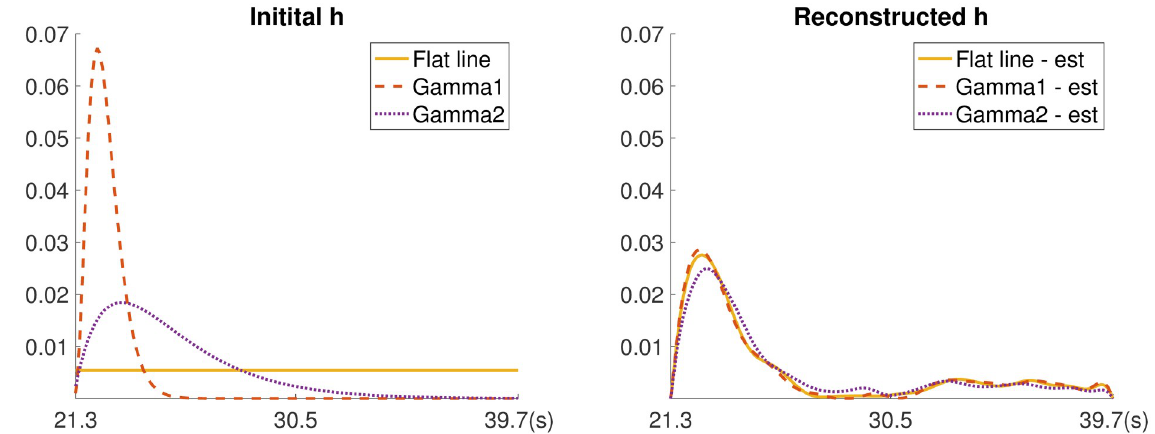
Fig 14. Impulse response function reconstruction for nonlinear case study. Initial guess for the unknown impulse response function (left) and reconstructed impulse response functions using a nonlinear respirometry reconstruction algorithm (right).